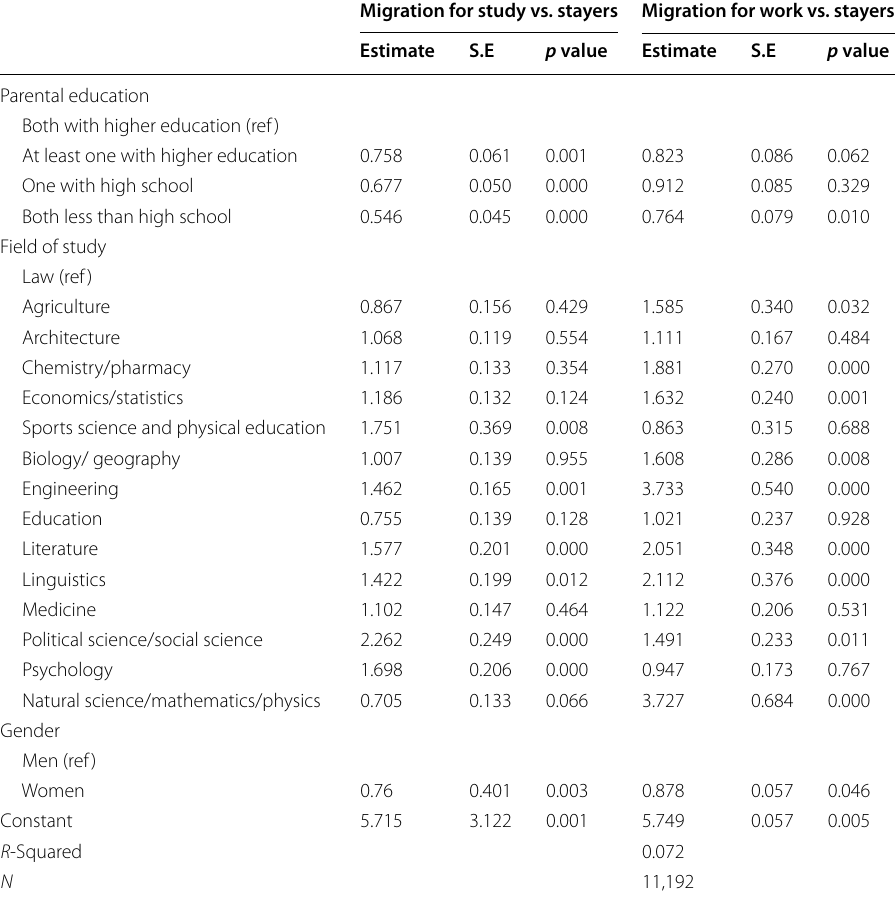
Table 2 Probabilities of migrating to study and work related to stayers Migration for study vs. stayers Migration for work vs. stayers Estimate S.E p value Estimate S.E p